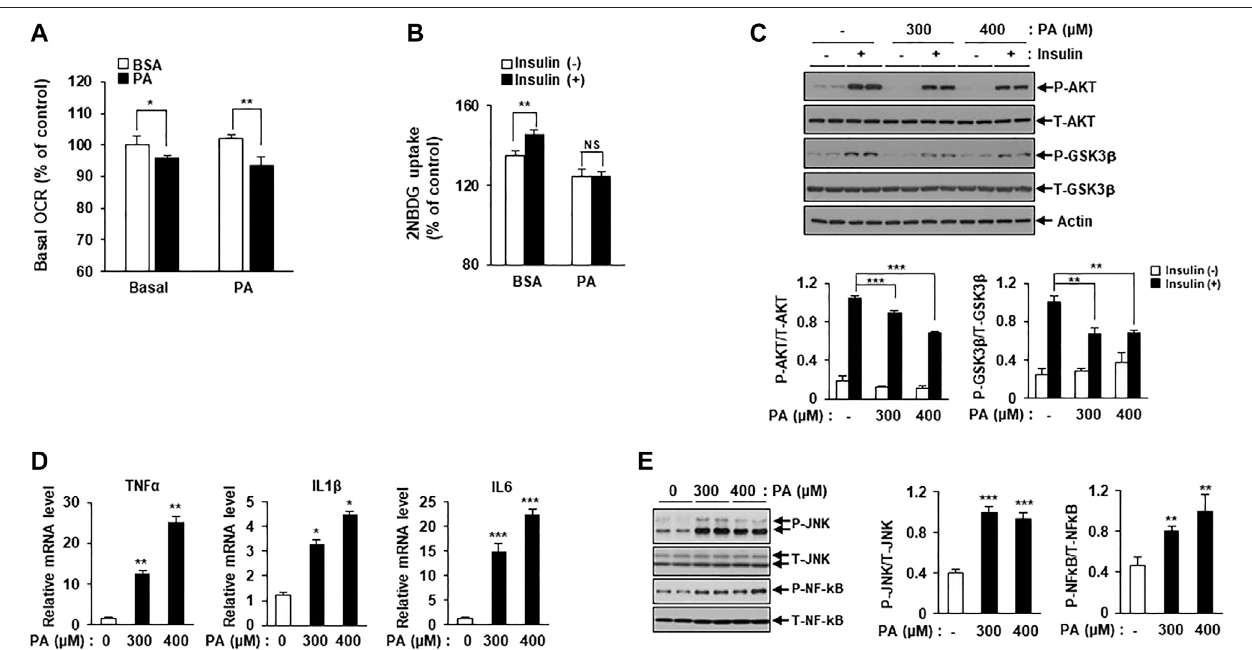
FIGURE1 | PAinduces mitochondrial dysfunction and lipotoxicity. (A) Differentiated C2C12 myotubes weretreated with or without 400 μ M PAfor 12 h. The OCR of PAwas measured using the Seahorse XF Analyzer (Agilent). * p < 0.05; ** p < 0.01 vs. PA-untreated cells. (B) C2C12 myotubes were treated with 400 μ M PA for 12h, and then stimulated with insulin at 100 nM for 3 h. 2-NBDG uptake was measured using a SpectraMax iD3 microplate reader (excitation: 475 nM; emission: 550 nM). ** p < 0.01 vs. 2-NBDG uptake after insulin treatment. (C) After treatment with 300 or 400 μ M PA, insulin resistance in C2C12 myotubes was determined by measuringp-AKTandp-GSK3 β byWesternblot.** p < 0.01;*** p < 0.001vs.insulin-stimulatedandPA-untreatedcells. (D) C2C12myotubeswereincubatedwith300or 400 μ M PA for 12 h, after which in fl ammatory cytokine gene expression was measured by real-time PCR. * p < 0.05; *** p < 0.001 vs. PA-untreated cells. (E) The expression levels of the in fl ammatory protein markers p-JNK and p-NF-kB were measured by Western blot. ** p < 0.01; *** p < 0.001 vs. PA-untreated